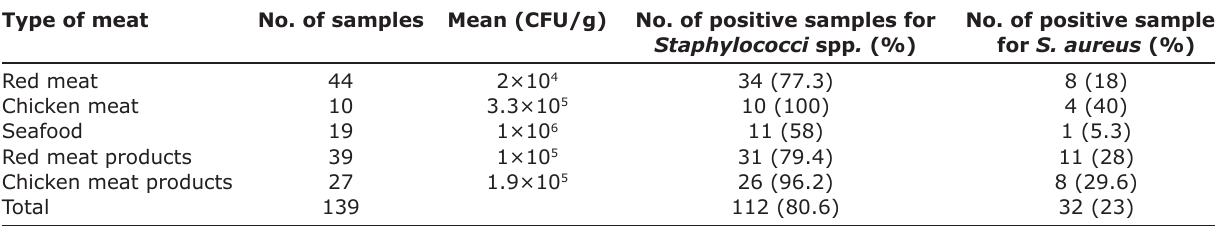
Table-1: Incidence of Staphylococci spp. and S. aureus in different meat, meat products, and some seafood samples on Baird-Parker medium. Type of meat